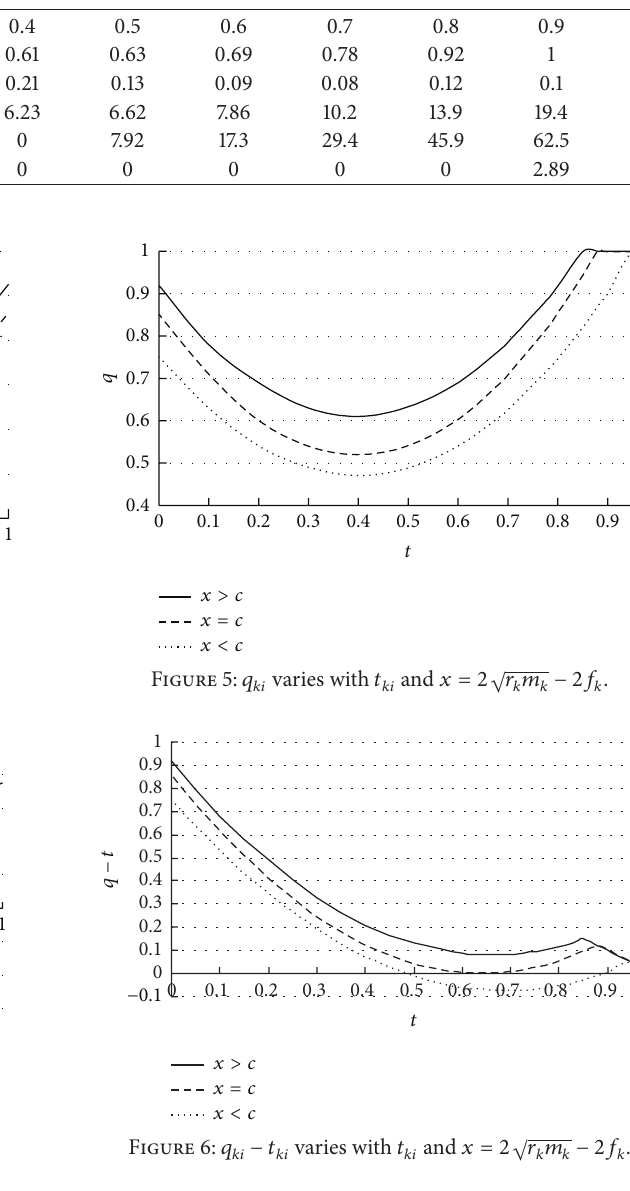
capacity; 𝑡 𝑘𝑖 ≥ 𝑡 𝑘0 ⇒ (𝜕𝐸 𝑘𝑖𝑗 /𝜕𝑡 𝑘𝑖 ) ≥ 0 , to the applicant with capacity higher than 𝑡 𝑘0 = (𝑐 𝑘 /2𝑟 𝑘 ) , the initiative of the applicant would be higher with higher